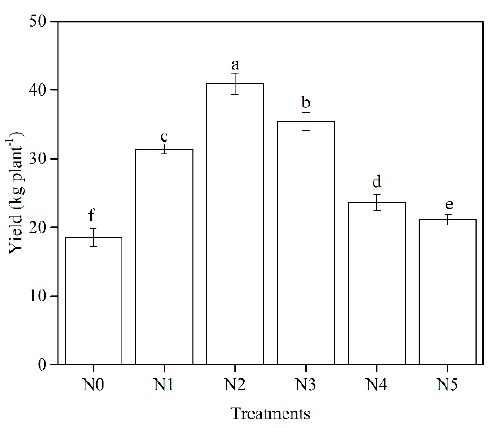
Figure 1. Citrus yields under different nitrogen fertilization treatments. Different letters indicate significant differences at p < 0.05 level (ANOVA).